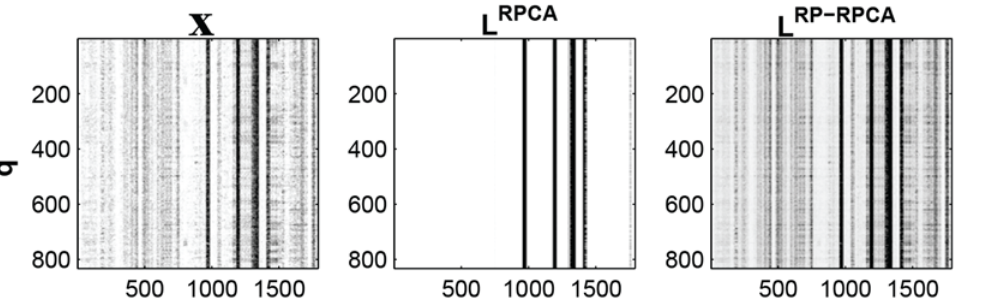
Fig 3. The low-rank matrices from both RPCA and RP-RPCA. X = [ X 1 X 2 ... X n ] 2 R q × n (cid:2) N T is an input matrix and we choose m = n = 64 for the comparison (contrast represents activity of neuron. i.e., high contrast represents highly modulated neural activity and white color represents zero neural activity). (left) raw-data (center) low-rank component using RPCA and (right) low-rank component using